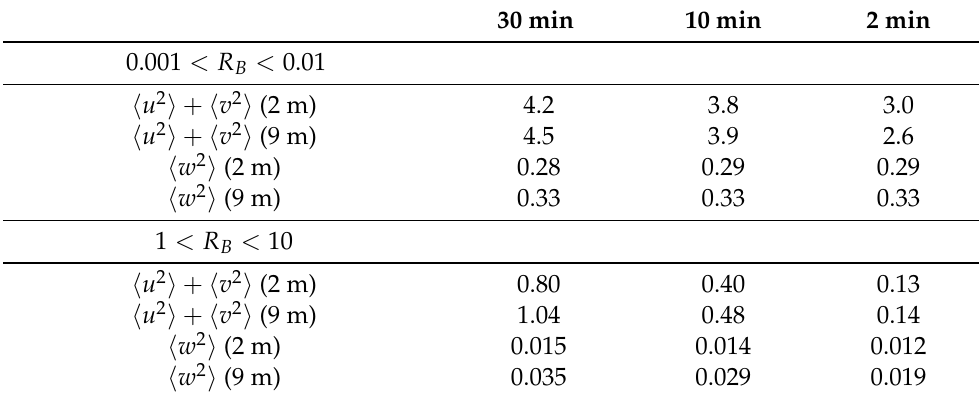
Table 1. Median values for horizontal and vertical velocity variances (in m 2 s − 2 ) measured at the two heights, for different stability conditions and different time intervals.